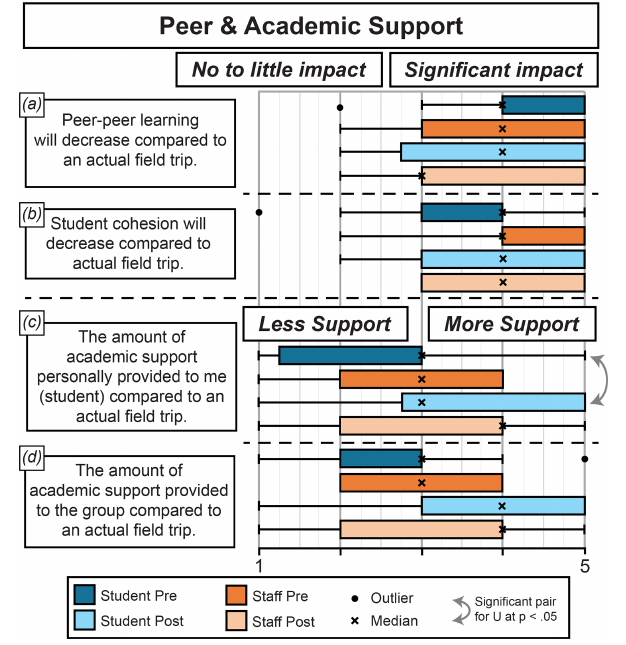
Figure 3. Quantitative responses to peer and academic